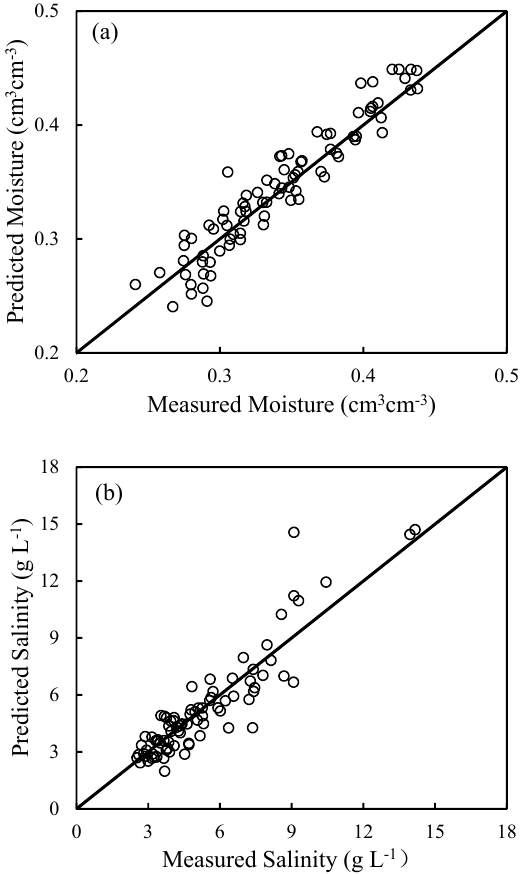
Figure 9. Sampling measurements versus EnKF estimates for soil with depths of 0–100 cm: ( a ) moisture; ( b ) salinity. The black circles represent the ensemble mean versus measurements at different time steps, and the solid black 1:1 diagonal line represents a perfect prediction.